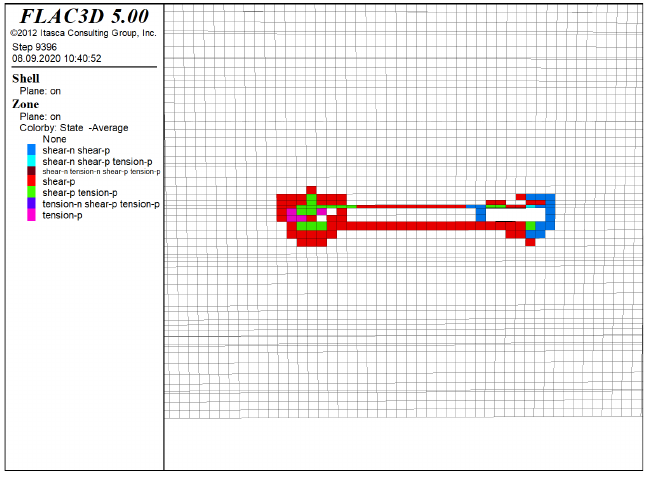
Figure 20: Plasticity around the longwall face with hydraulic backfilling (sand).